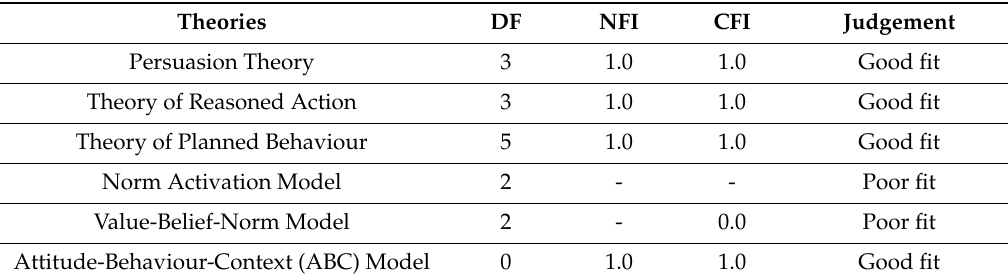
Table 7. Model fit indices.